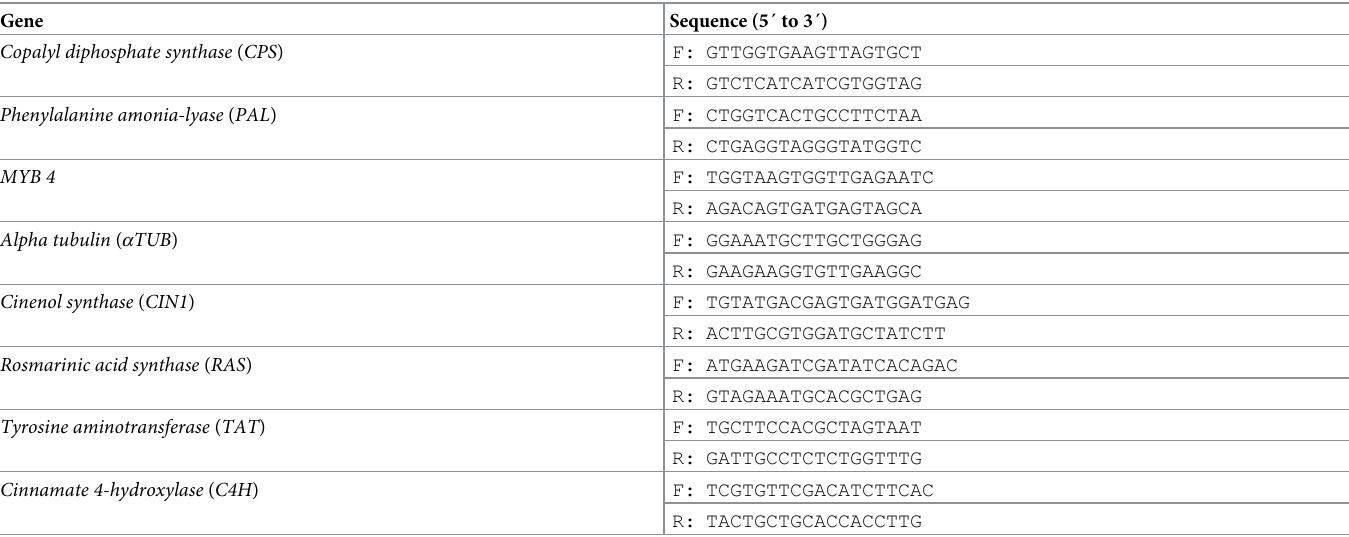
Table 1. The sequences of specific primers used to the Real-time